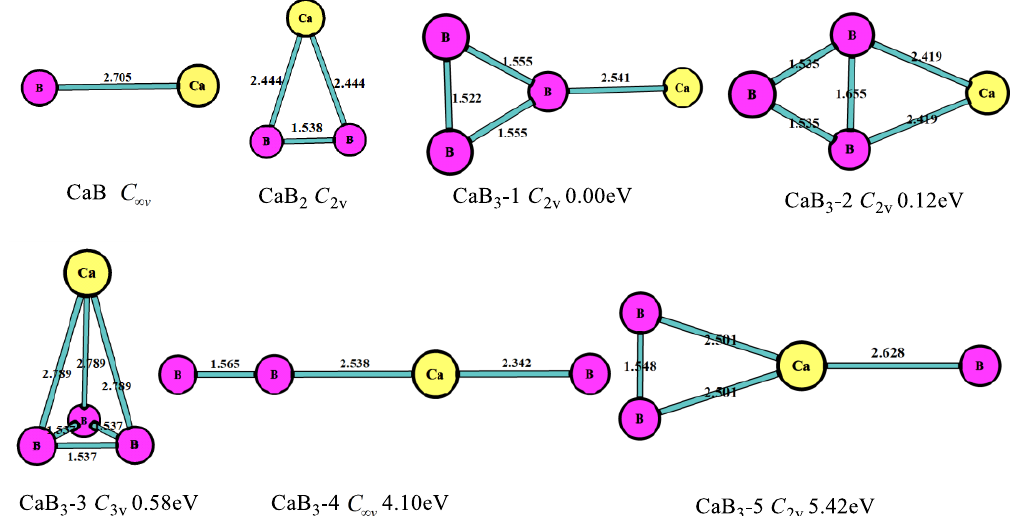
Figure 1. Geometry of the CaB n (n = 1–3) clusters obtained at MP2/6-311+G(d)//B3LYP/6-311+G(d). The bond length unit is Å.